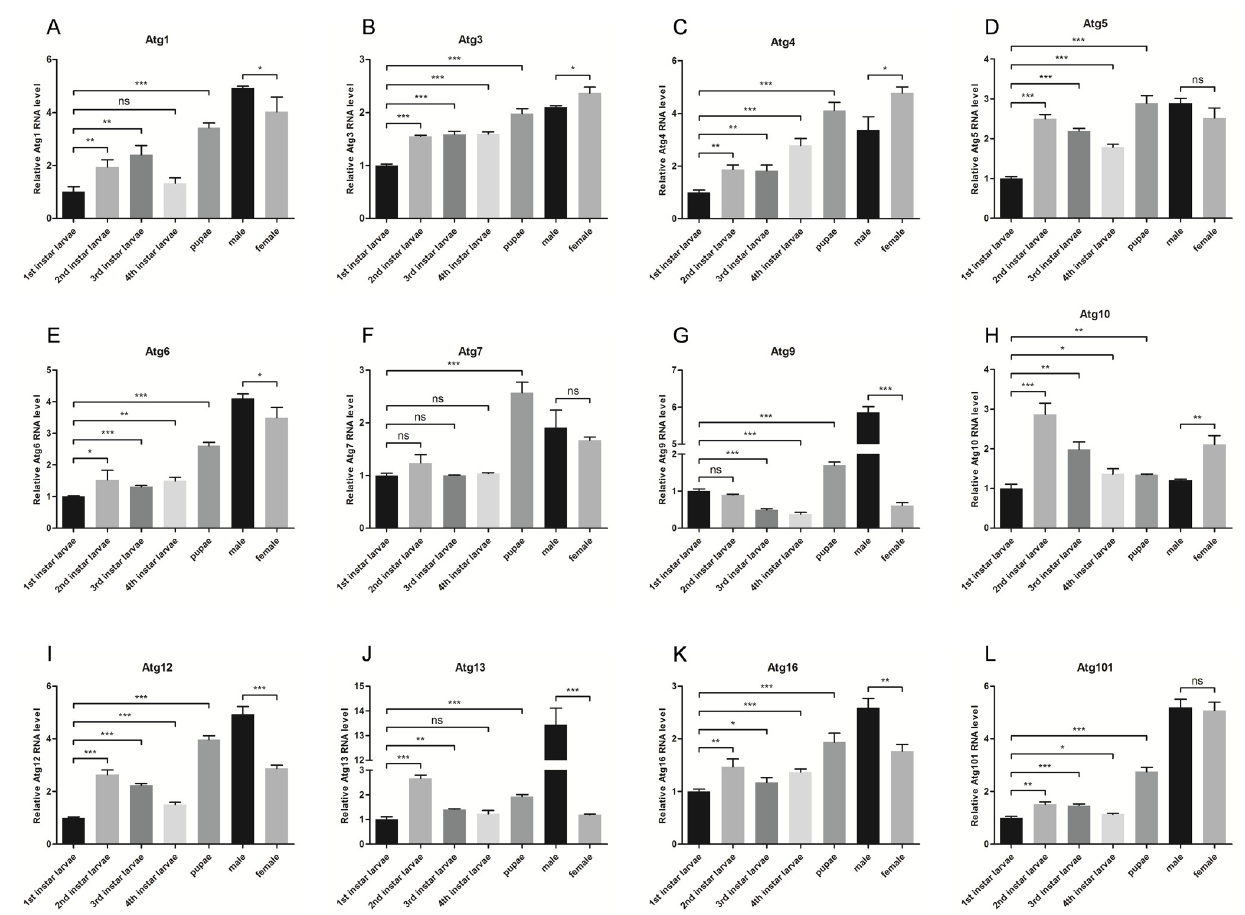
Fig 3. Expression profiles of Aaatg genes in developmental and adult stages of Aedes albopictus . (A)—(L) RNAs were prepared from 1st to 4th instar larvae, pupae, male and female adults and subjected to qPCR analysis. The vertical axis represents the relative expression level of Aaatg gene in different development stages or genders to housekeeping gene Aas7 . Data were presented as means ± SD for three biological replicates. The statistical significances were calculated by t test, ns P > 0.05, � P < 0.05, �� P < 0.01, ��� P < 0.001.